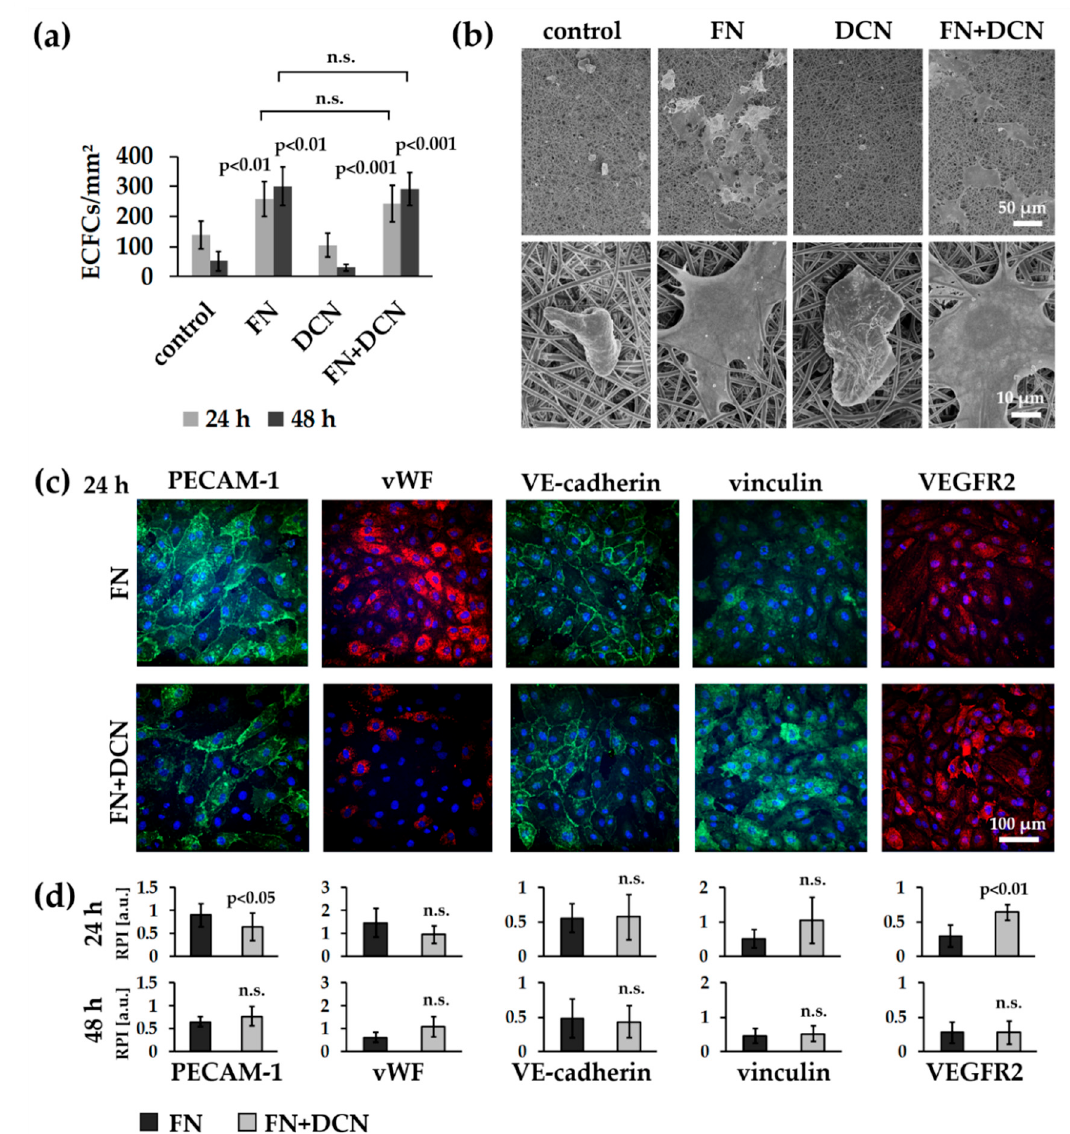
Figure 5. Static experiments of human ECFCs on FN-, DCN-, or FN + DCN-coated sca ff olds: ( a ) Attachment and proliferation of the human ECFCs after 24 h and 48 h. Cells on FN and FN + DCN coating show a significantly higher proliferation when compared with cells gown on DCN and controls. Two-tailed t -test, compared to controls, n = 5, n.s. = not significant. ( b ) SEM images and ( c ) Immunofluorescence staining of ECFCs 24 h after seeding on ECM protein-coated sca ff olds: Cells on FN and FN + DCN show a spread morphology in contrast to DCN coating and controls. ( d ) Semiquantitative fluorescence intensity analysis (relative pixel intensity (arbitrary units)) of cells on FN and FN + DCN shows no significant di ff erence for the endothelial cell type marker von Willebrand factor (vWF) as well as vinculin and vascular endothelial cadherin (VE-cadherin). Platelet endothelial cell adhesion molecule (PECAM-1) expression is significantly decreased and VEGFR2 expression is significantly increased on FN + DCN-coated sca ff olds after 24 h. Two-tailed t -test, n = 6, n.s. = not significant.